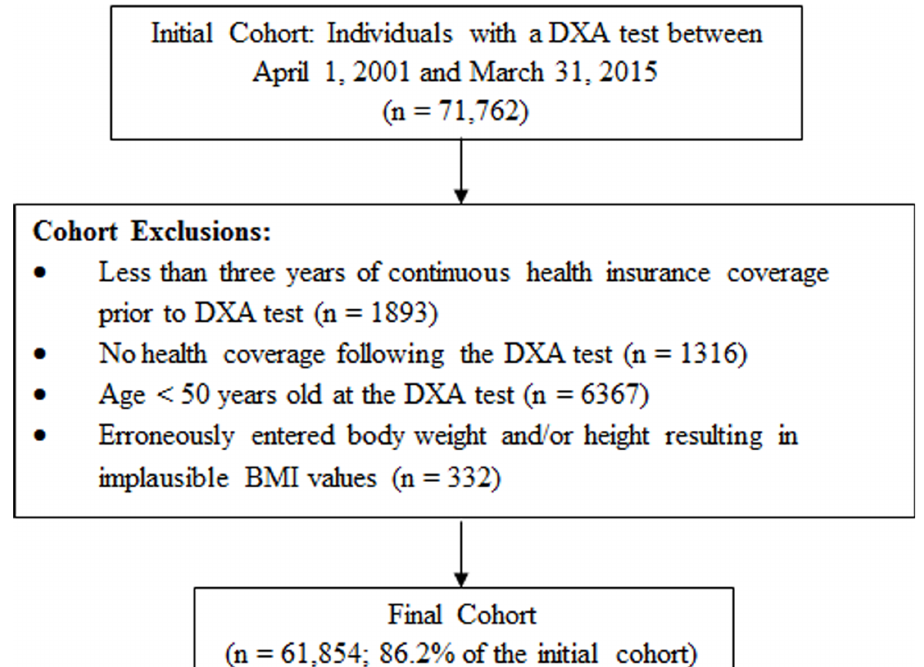
Fig 1. Flow chart for cohort selection and